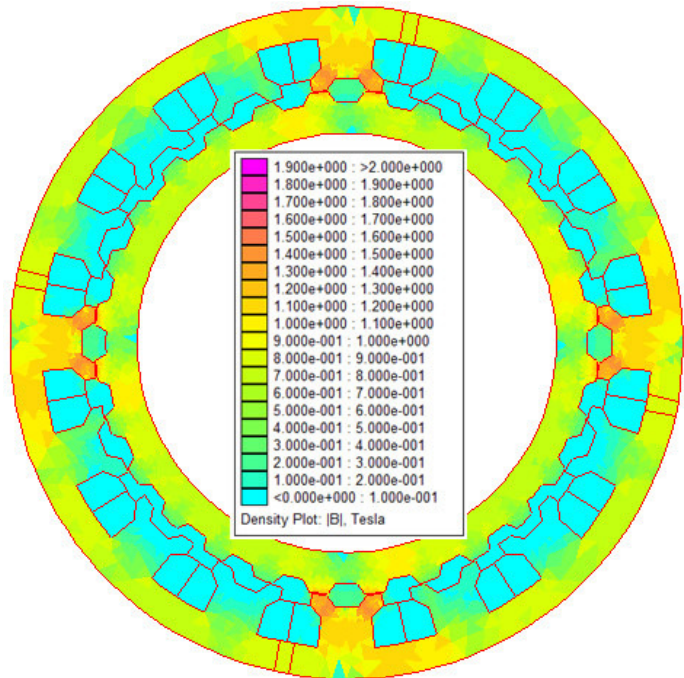
Figure 4. Conjunction (aligned) position and flux density